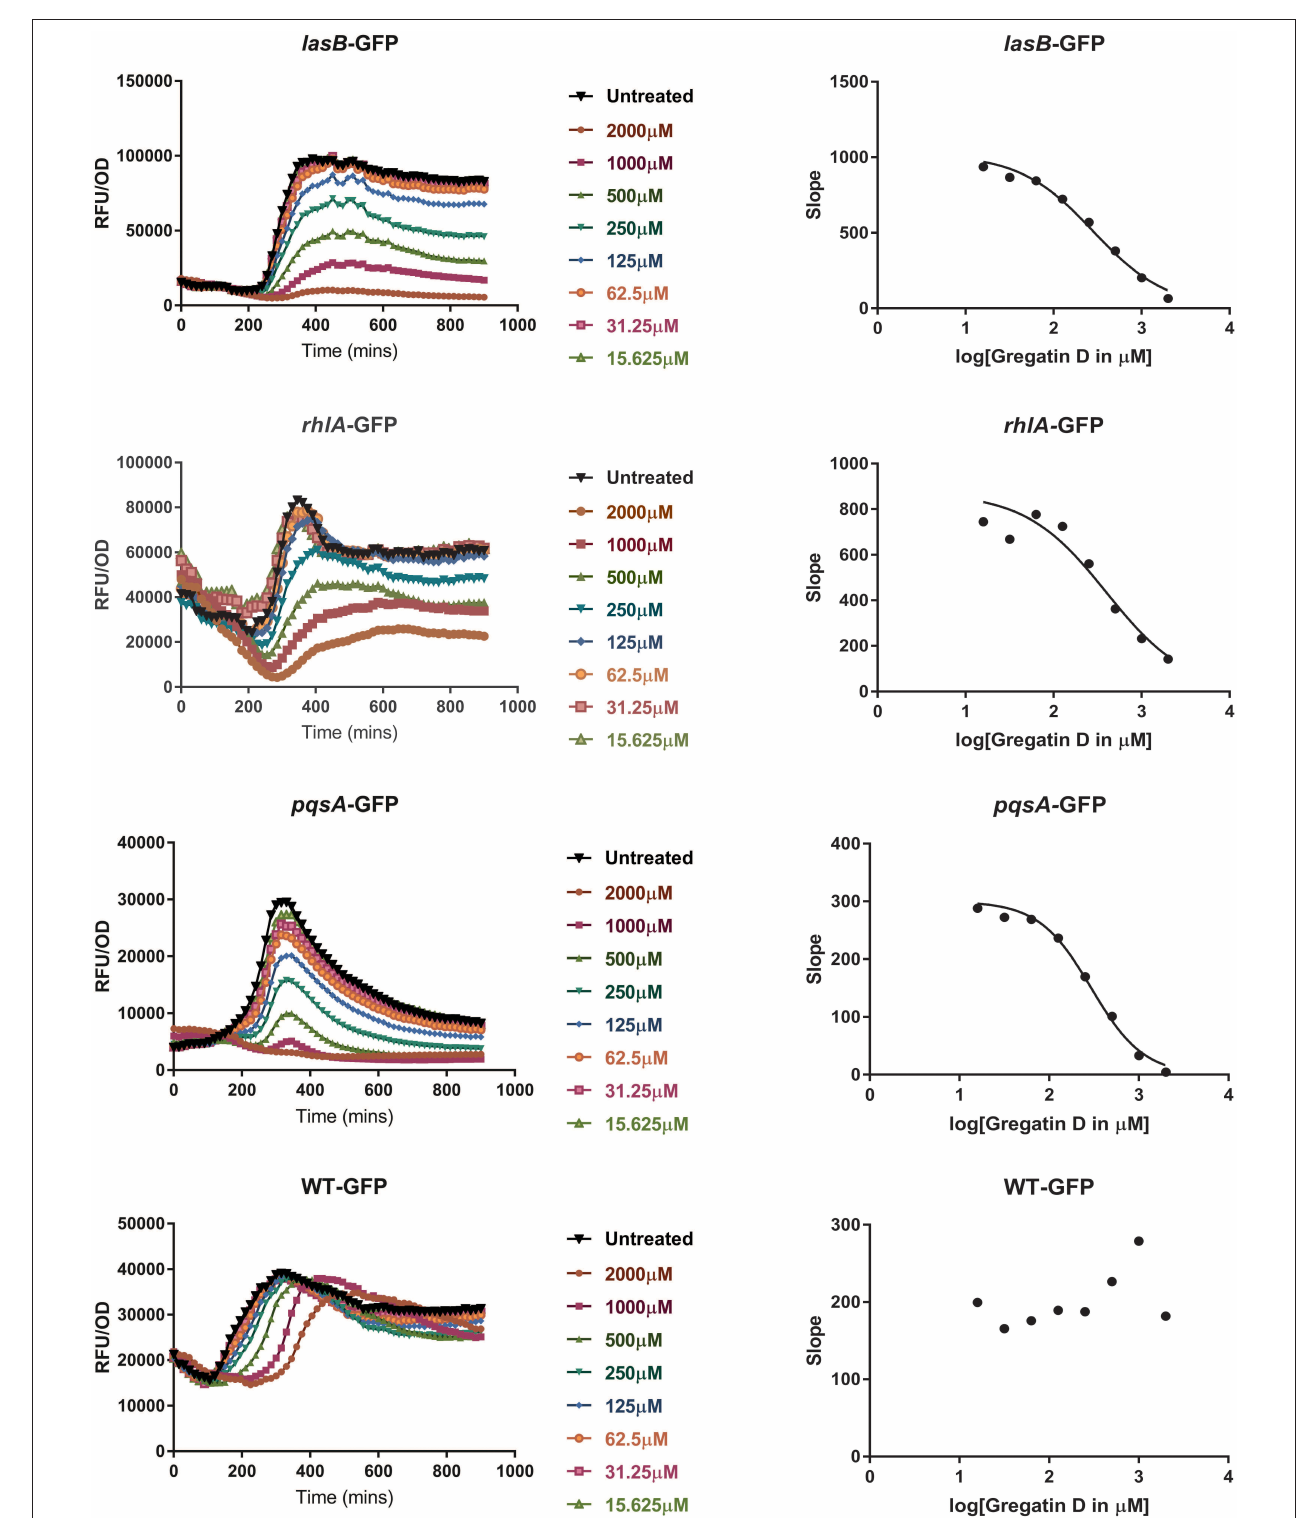
FIGURE 5 | QS inhibitor activity of gregatin D on Pseudomonas aeruginosa strain PAO1. Gregatin D was tested on the three QS reporters of P. aeruginosa and a WT-GFP control. The GFP signal was normalized by dividing the OD 600 values giving RFU/OD plots (graphs on the left). The maximum slopes are plotted (graphs on the right) by which the IC 50 was calculated. Experiments were done in triplicates, and the mean of RFU/OD was plotted and used for the calculations of the maximum slope.